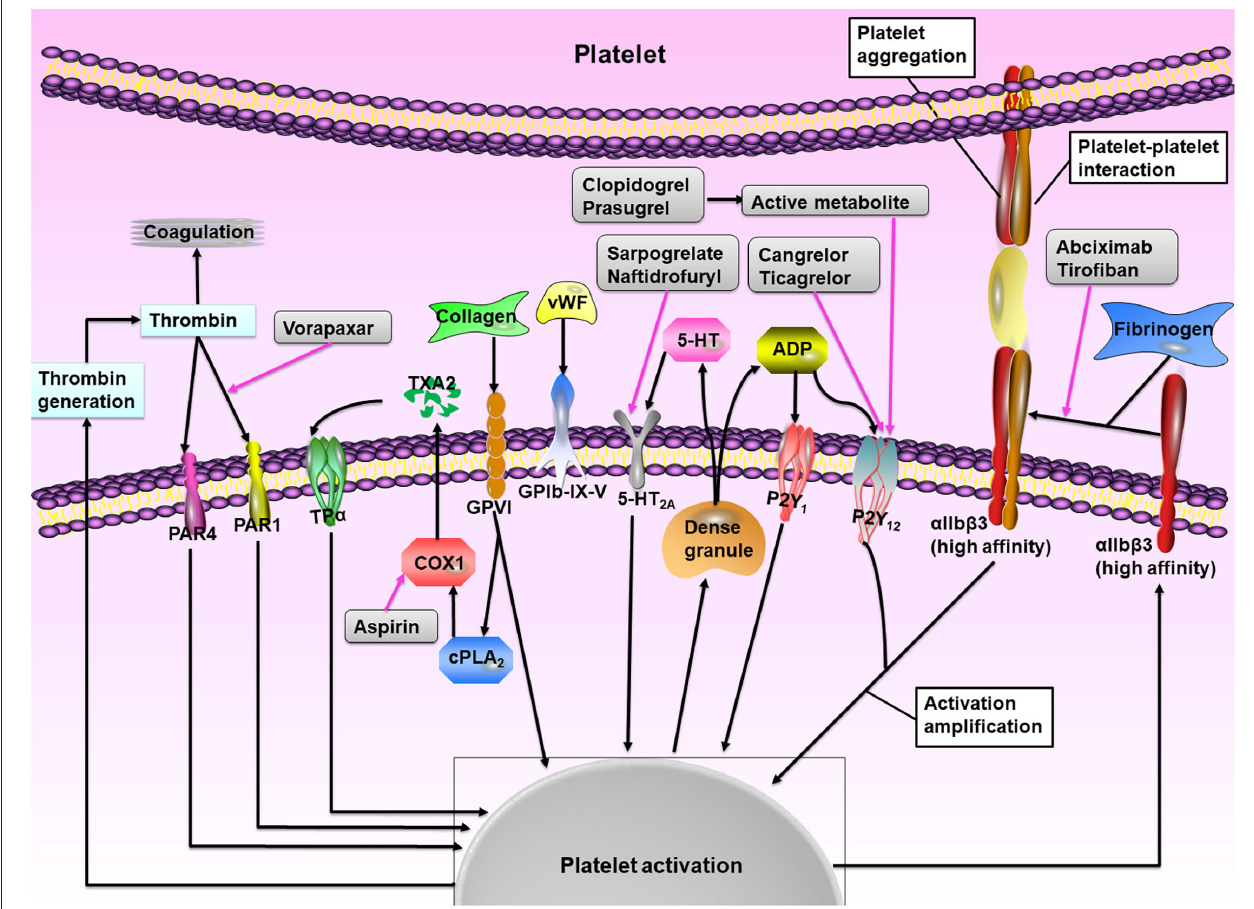
FIGURE 1 | The role of platelet activation. At the site of vascular injury, platelet adherence to the endothelium through the combination of glycoprotein (GP) receptors with exposed extracellular matrix proteins (particularly collagen and von Willebrand factor, vWF). Platelet activation occurs through complex intracellular signaling processes and leads to the release of various agonists, including thromboxane A 2 (TXA 2 ), ADP, and 5-hydroxytryptamine (5-HT), which act by binding to their respective G protein-coupled receptors and mediate paracrine and autocrine platelet activation. The receptor P2Y purinoceptor 12 (P2Y 12 ) has a major role in the amplification of platelet activation, which is also supported by outside-in signaling via α IIb β 3 integrin (the glycoprotein IIb/IIIa receptor). The main platelet integrin GPIIb/IIIa mediates platelet aggregation through conformational shape changes and binding to fibrinogen and vWF, thereby mediating the final common step of platelet activation. The net result of these interactions is thrombus formation mediated by the interaction of platelet aggregate with fibrin and thrombin. The available drugs (gray boxes) blockade different pathways of platelet activation and show additive inhibitory effects when used in combination. PAR, proteinase-activated receptor; TP α , TXA 2 receptor isoform- α ; COX1, cyclooxygenase 1. Adapted from Varga-Szabo et al. (